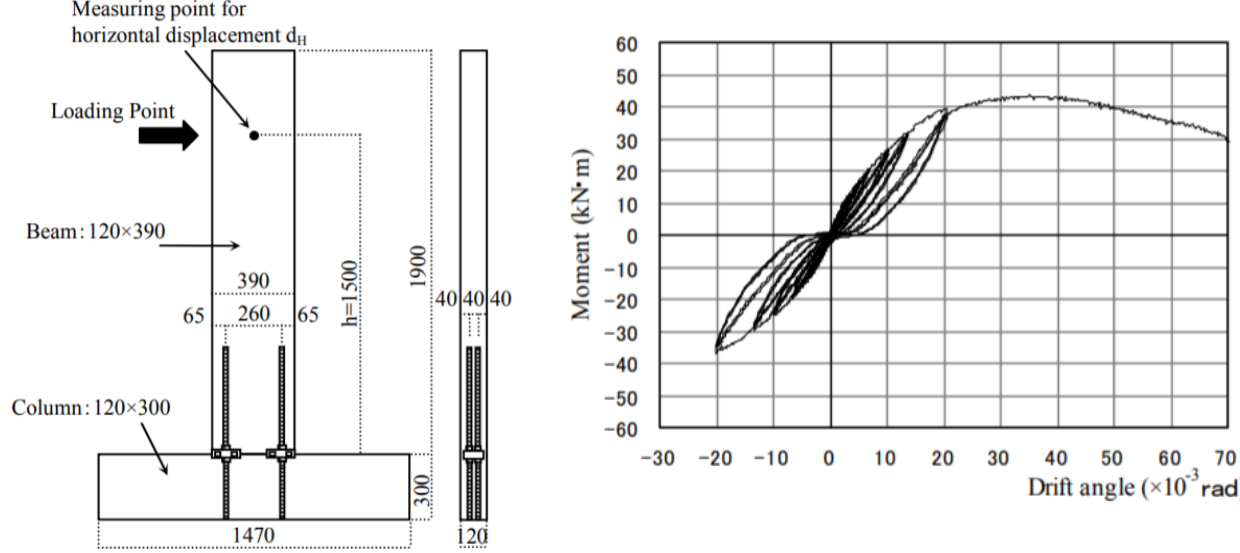
Figure 4. Bolted steel plate connection and moment–rotation curves for cyclic load for beam-to- column joint, adapted from [15].